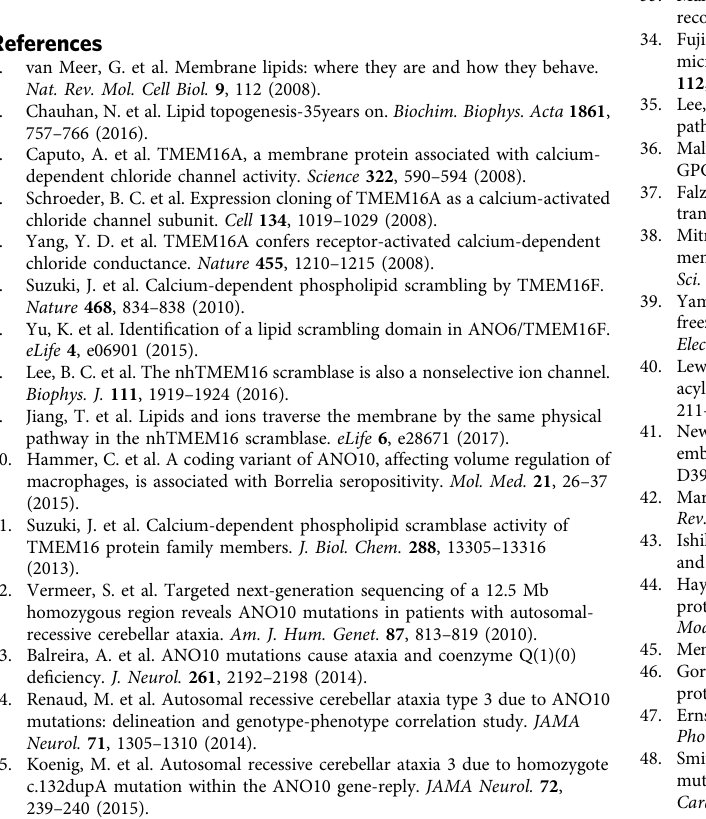
Fig. 2h, Supplementary Figs. 1b and 3a − f are provided as a Source Data fi